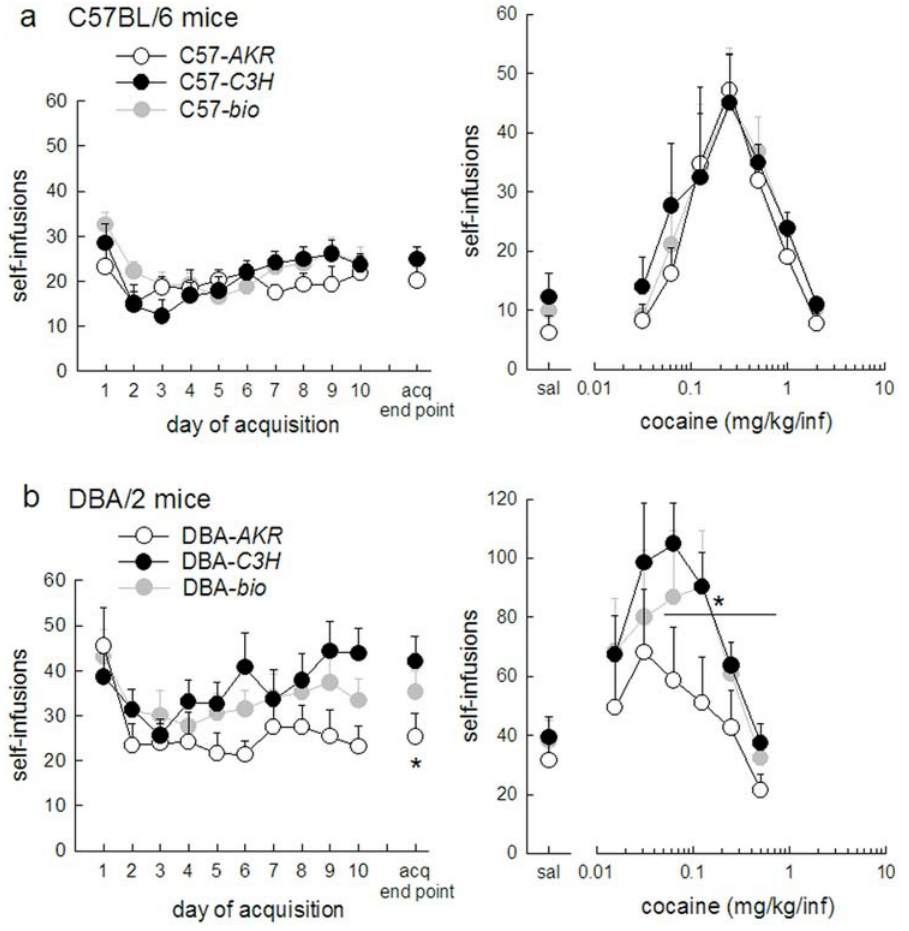
Figure 4. Impact of maternal environment on cocaine intravenous SA in C57 and DBA mice. Graphs show the number of self-infusions obtained in (a) C57 mice in acquisition at 1 mg/kg/infusion (left panel) and dose-response curve (right panel) (b) DBA mice in acquisition at 0.5 mg/ kg/infusion (left panel) and dose-response curve (right panel). The symbols in the dose-response graph represent the last two days of stable intake on a dose. Behavior of the reference groups (- bio ) is shown with grey lines and symbols. Horizontal lines show the data submitted to statistical analysis. Symbols represent mean 6 SEM. C57- AKR (white circles) n =5, C57- C3H (black circles) n =8, C57- bio (grey circles) n =8, DBA- AKR (white circles) n =8, DBA- C3H (black circles) n =11, DBA- bio (grey circles) n =10. * p , 0.05 compared to DBA- C3H.